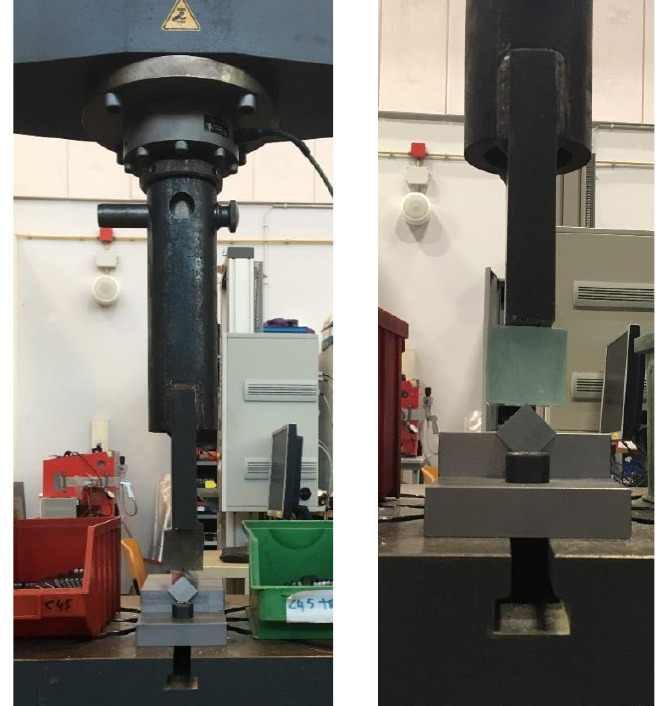
Figure 7. Splitting test set-up.